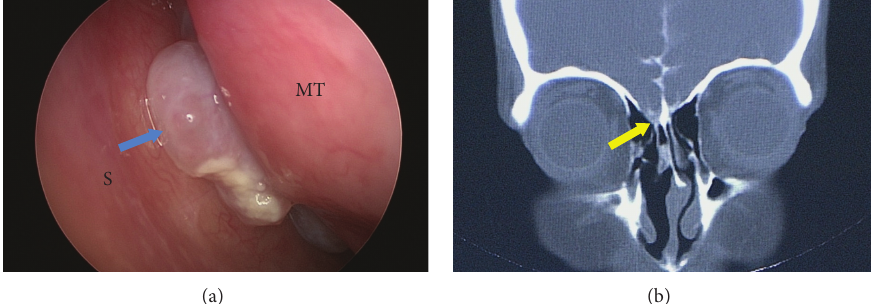
Figure 2: Patient number 2. (a) Left meningocele (arrow) between the nasal septum (S) and middle turbinate (MT). (b) CT myelography showing a defect at the level of the cribriform plate (arrow